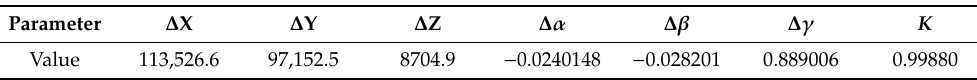
Table 5. Conversion parameters from the receiver array single station system (RASS) coordinate system to the total station (RTS) coordinate system, where ∆ X , ∆ Y , and ∆ Z are translation parameters, and ∆ α , ∆ β , and ∆ γ are rotation parameters; K is a scale factor.